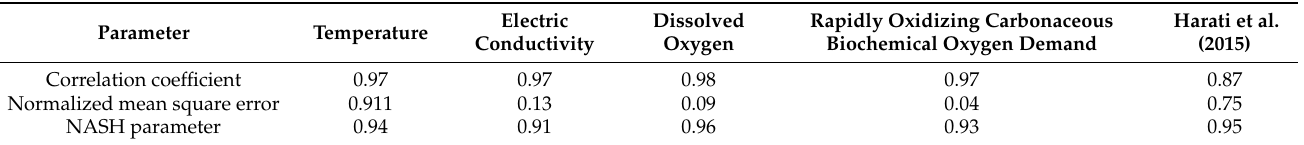
Figure 10. ( a ) Simulation of dissolved oxygen (DO); and ( b ) biochemical oxygen demand (BOD) along the Maroon and Jarahi Rivers. Table 7. Test statistics in the validation stage.